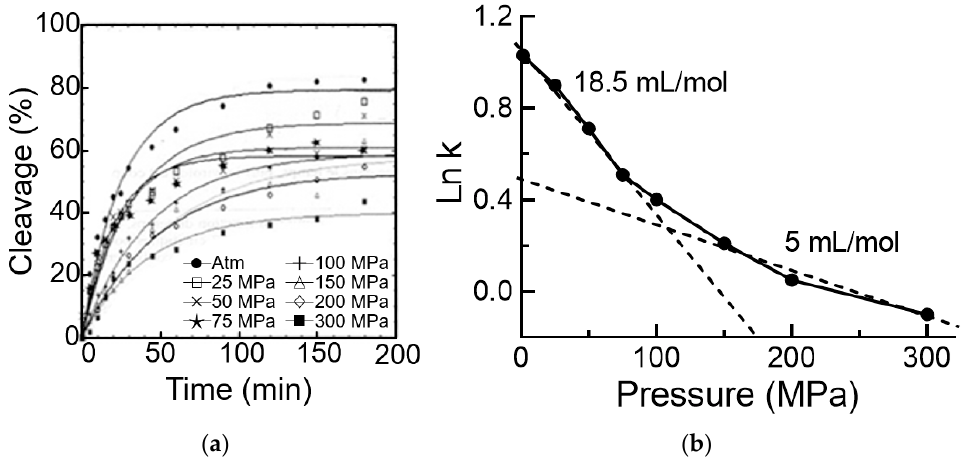
Figure 2. Kinetics of the ASBVd(–) self-cleavage reaction. ( a ) Time course of the reaction at 30 °C and different pressures. ( b ) Plot of Ln k against pressure providing the activation volumes of the reaction.